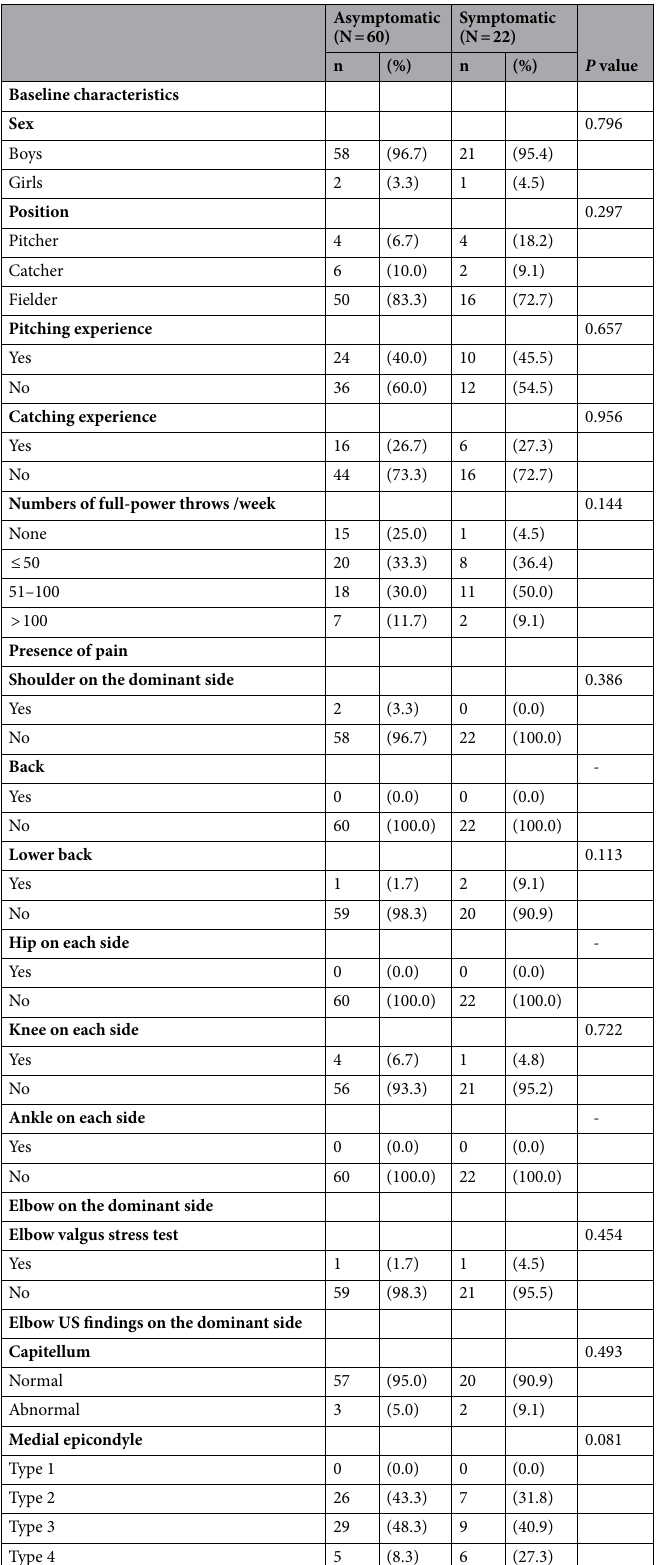
Table 2. Demographic data (categorical data). US,